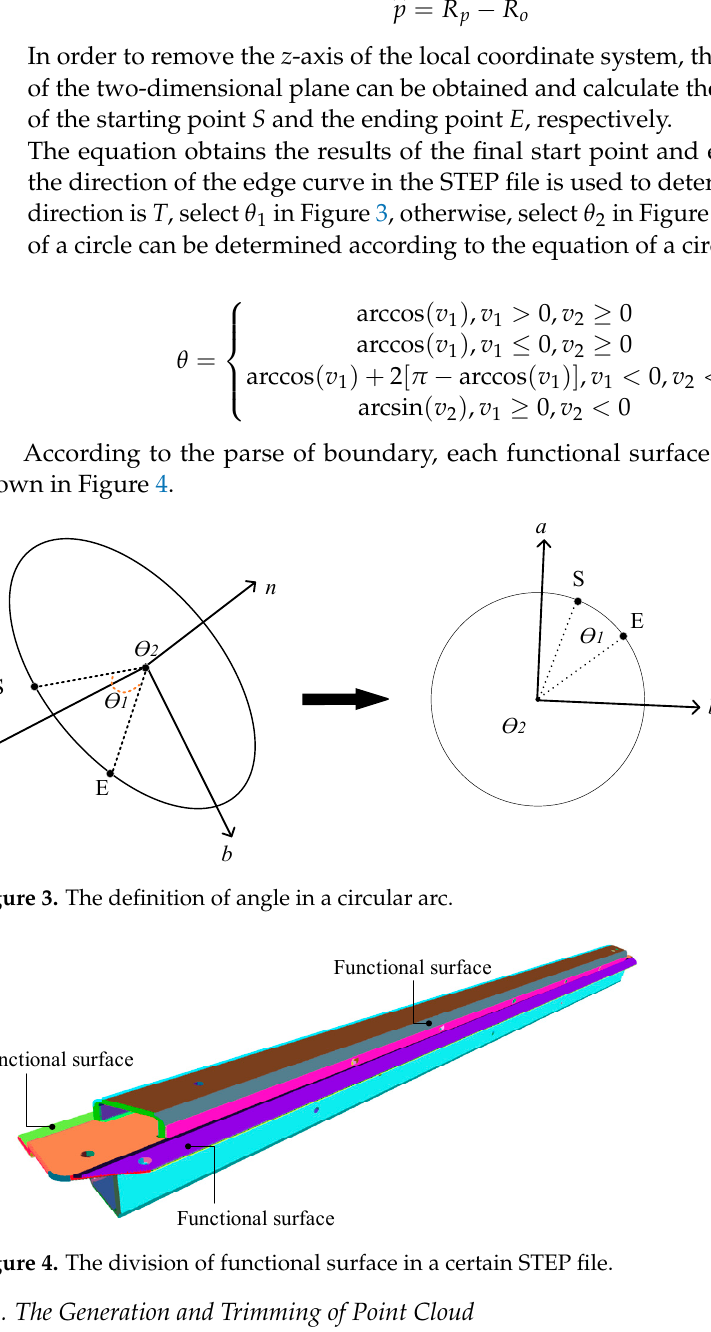
( b ) Figure 5. The procedure of plane point cloud trimming : ( a ) The point cloud of the plane before trimming; ( b ) The trimmed point cloud through the ray casting method. POINT1POINT2 POINT1POINT2 ( a ) ( b ) Figure 6. The illustration of the ray casing method. ( a ) A polygon includes a curve; ( b ) A curve is reduced to a polygon with multiple straight lines.